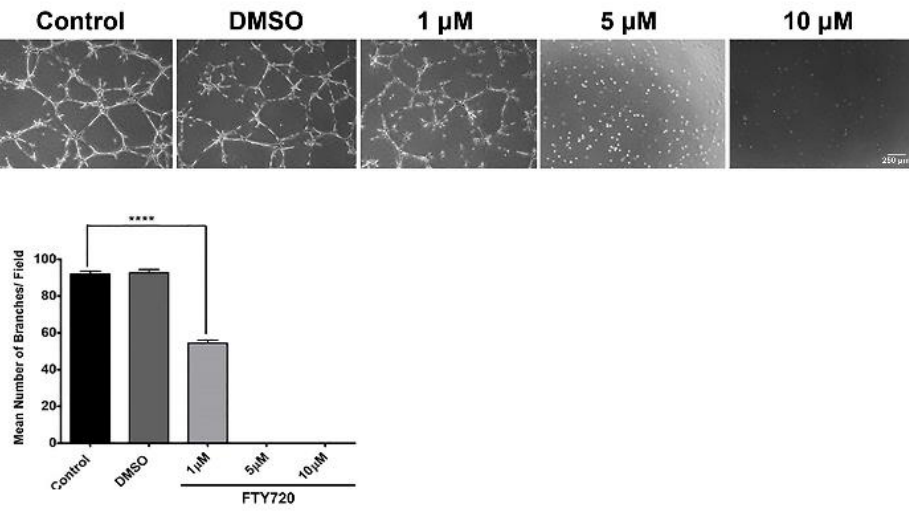
Figure 6. An enantiomer of the phosphorylated S1PR agonist FTY720 inhibits ChEC capillary mor- phogenesis. Detached ChECs were incubated with varying concentrations of phosphorylated S1PR agonist (in DMSO) or DMSO on ice for 20 min. Incubated cells were then applied to Matrigel-coated plates, incubated, and photographed after 14 h as described in Methods. The mean number of branch points was determined. *** p < 0.001, **** p < 0.0001. ( n = 3). Due to S1PR1 having the highest level of expression in ChECs, we next focused on the impact S1PR1 has during capillary morphogenesis. Agonizing S1PR1 in ChECs with increasing concentrations of CYM5442 (a selective S1PR1 agonist) resulted in a steady de- cline in the ability of these cells to undergo capillary morphogenesis (Figure 7). Thus, sig- naling through S1PR1 prevents capillary morphogenesis, as previously demonstrated [27].